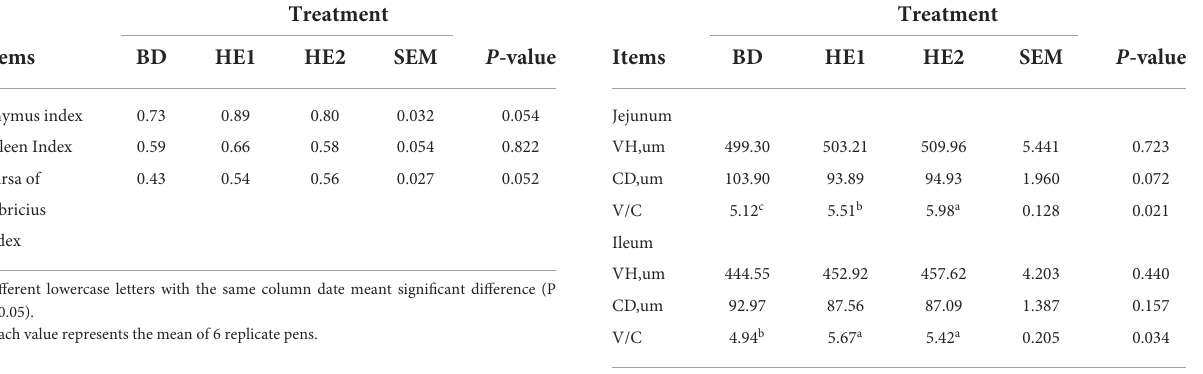
TABLE 3 Effect of HE on immune organ index a .